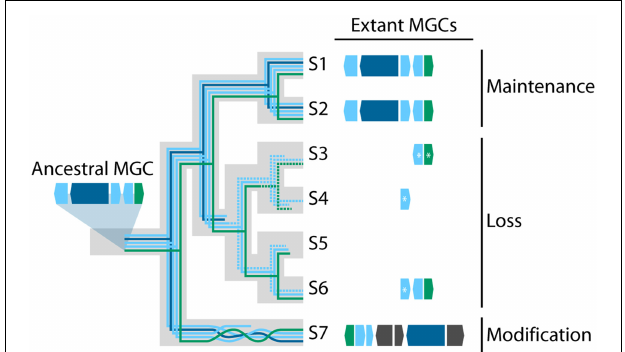
FIGURE 1 | Three evolutionary fates of transferred MGCs. In this hypothetical example, a five gene MGC is transferred into the common ancestor of seven species of fungi (taxa S1–S7). The large gray tree represents the underlying species phylogeny, and each colored line represents the evolutionary history of a gene within the MGC. Dashed lines indicate genes that have been pseudogenized and are no longer functional. Extant MGCs in taxa S1 and S2 have maintained the same number of genes in the same orientation as the ancestral MGC suggesting purifying selection has acted to preserve the MGC’s original form and function. In contrast, taxa S3–S6 contain the MGC in varying stages of decay, indicative of neutral evolution or positive selection for its loss. Asterisks ( ∗ ) indicate pseudogenes. Finally, the MGC in taxon S7 has been modified from its original form, having undergone gene rearrangement, gene loss, and recruited three additional genes (colored in dark gray), which suggests the MGC has experienced diversifying